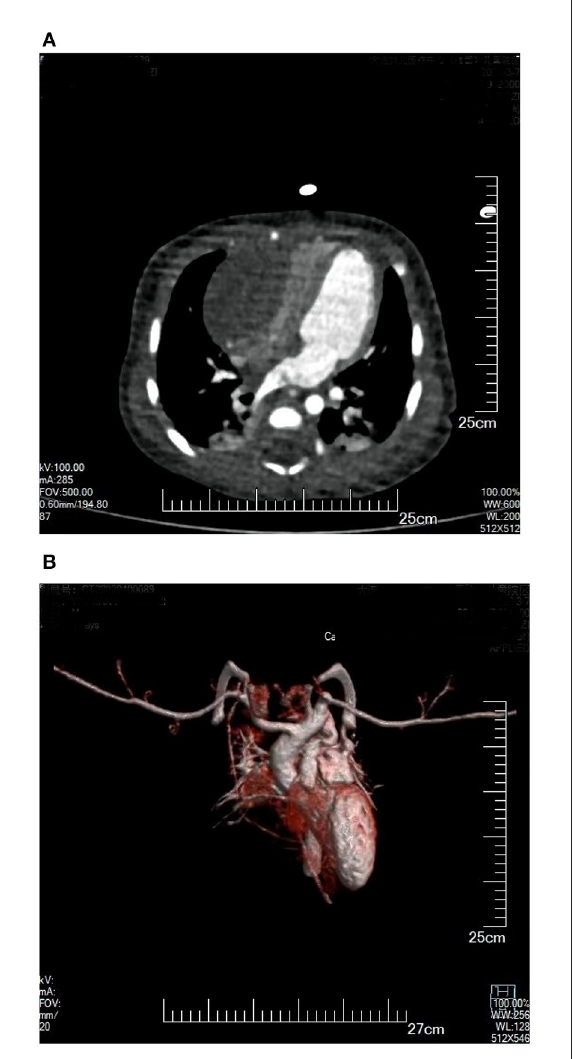
FIGURE2 (A) Plain CT scan: Enormous space-occupying mass on a right ventricular wall, with compressed right ventricle cavity. (B) 3D reconstruction of cardiac blood flow: The right ventricular inflow tract was compressed by tumor, without obvious blood flow